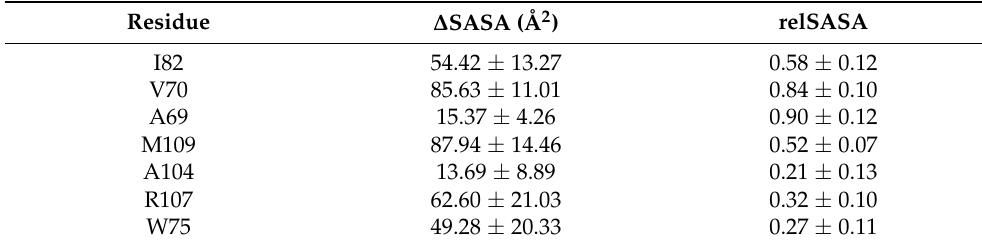
Table 6. ∆ SASA and relSASA for highlighted